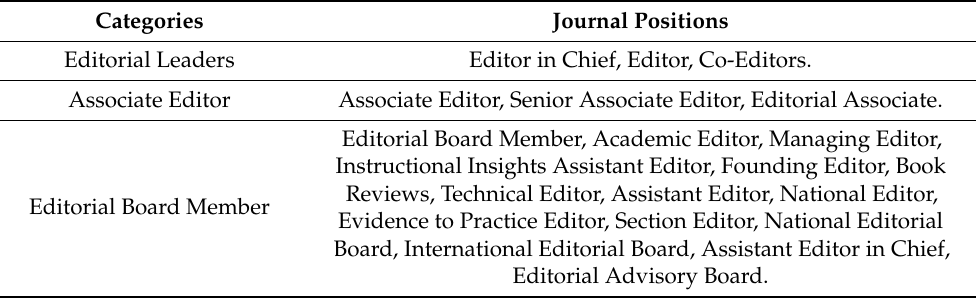
Table 1. Categories established for this study to group the different positions.